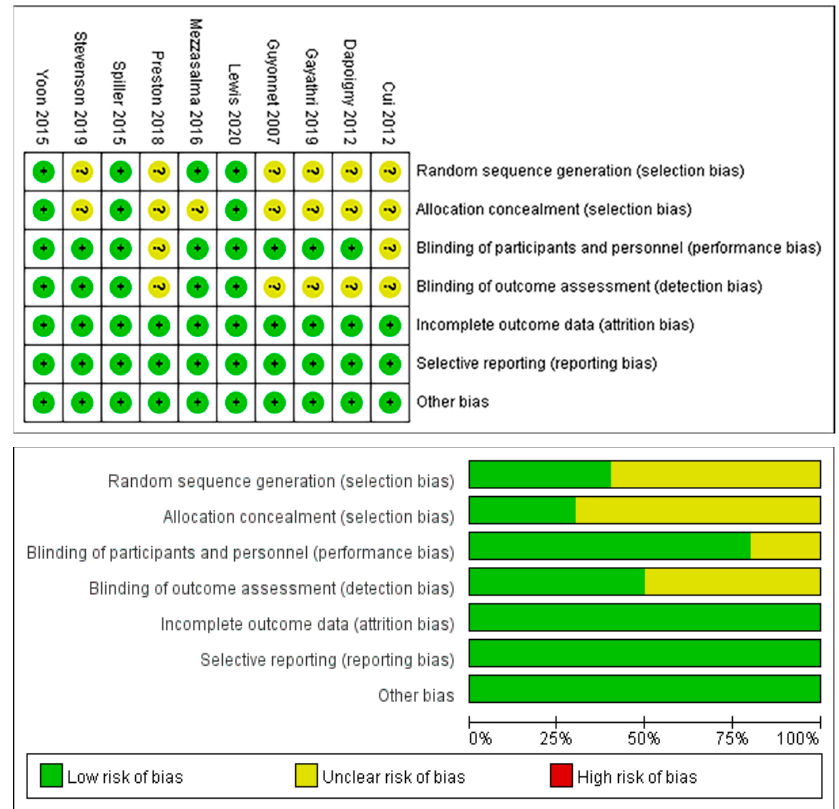
Figure 2. Risk of bias assessment for the included studies